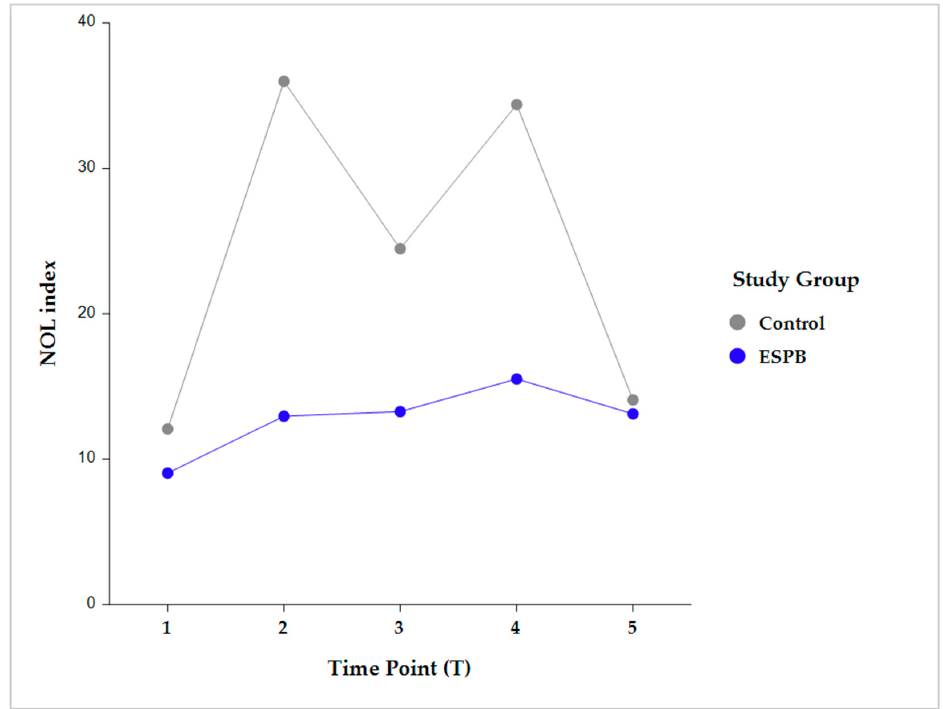
Figure 4. Pairwise intragroup comparison (Control, ESPB) between consecutive NOL index time points. Time point comparisons: pre-incision (T1) vs. post-incision (T2); T2 vs. pre-sternotomy (T3); T3 vs. post-sternotomy (T4); and T4 vs. pre-CPB (T5). The data are presented as least square adjusted means. Control group: p < 0.001 for all consecutive pairwise comparisons. ESPB group: lack of statistical significance for all consecutive pairwise comparisons. Analysis was performed using a mixed model for repeated measurement with random intercepts for patients and fixed effects for group, time, and the interaction of group and time. CPB, cardiopulmonary bypass; ESPB, erector spinae plane block; NOL, nociception level.